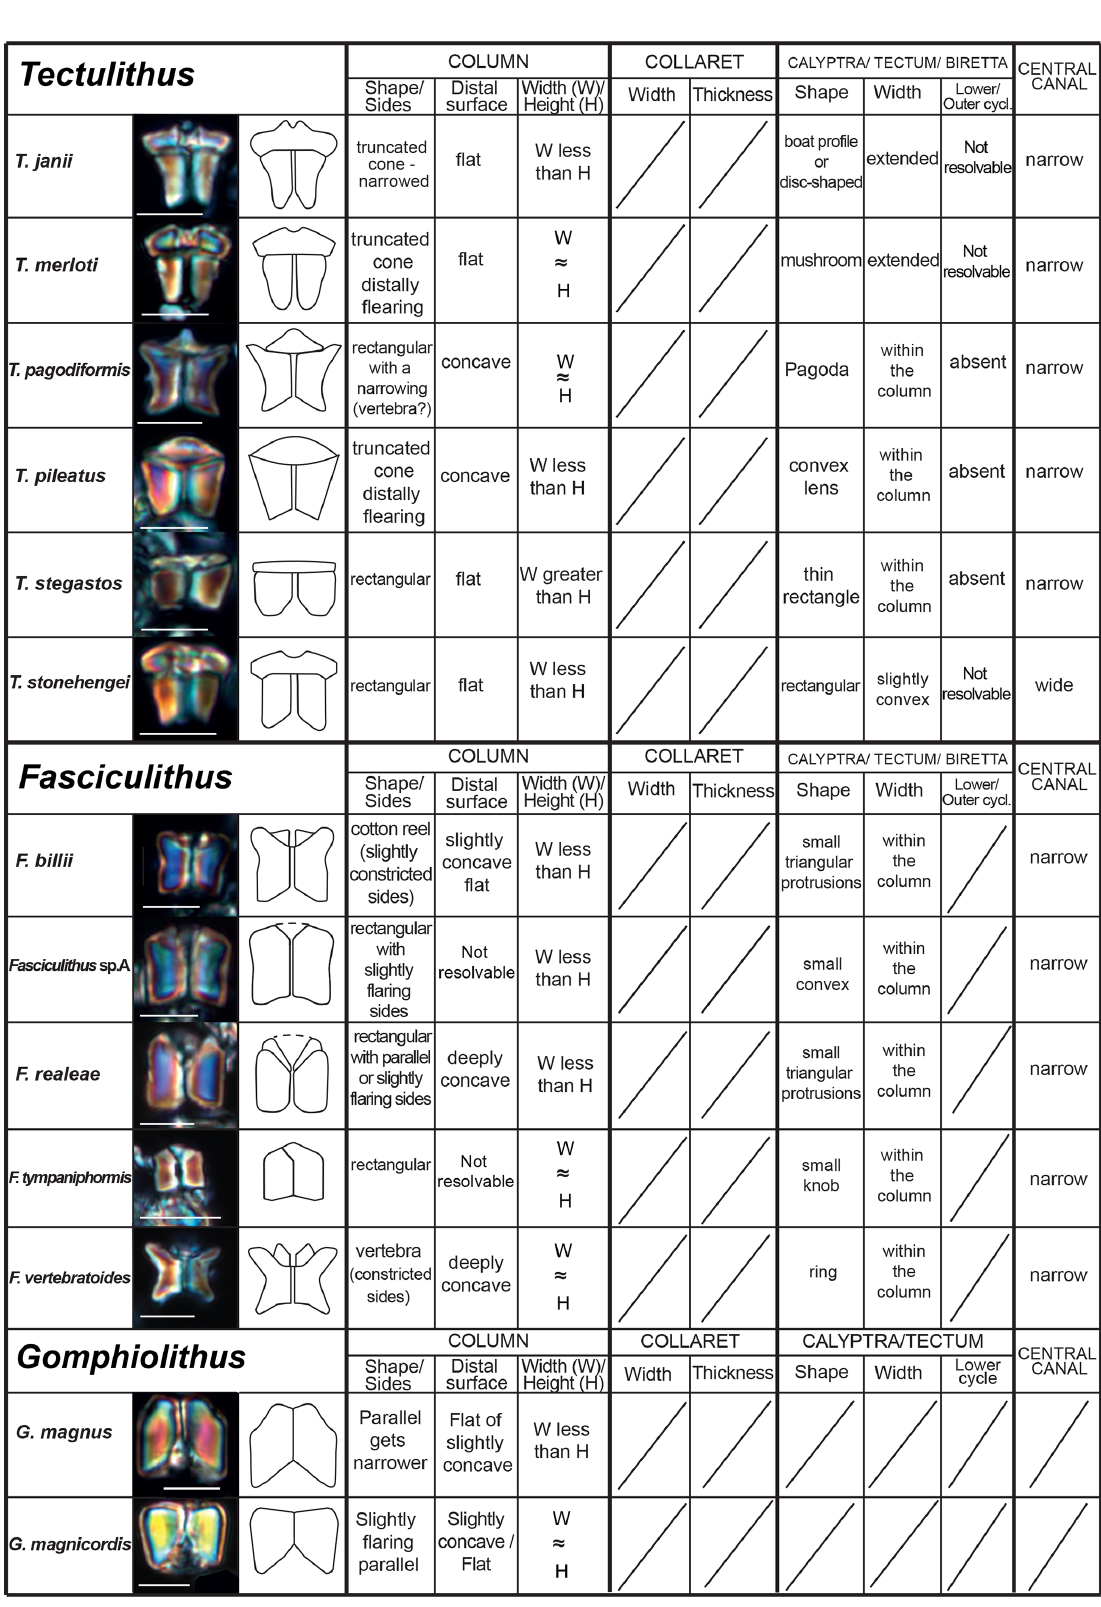
Figure 4. Scheme of the main characteristics to identify Tectulithus, Fasciculithus and Gomphiolithus . Scale bar 5µm.